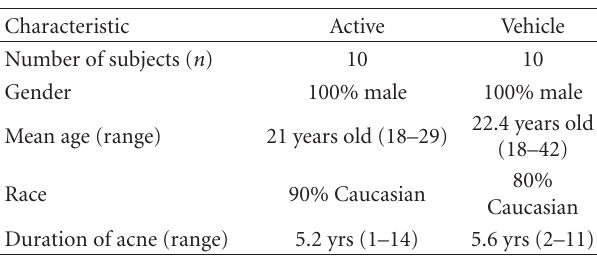
Table 5: Patient